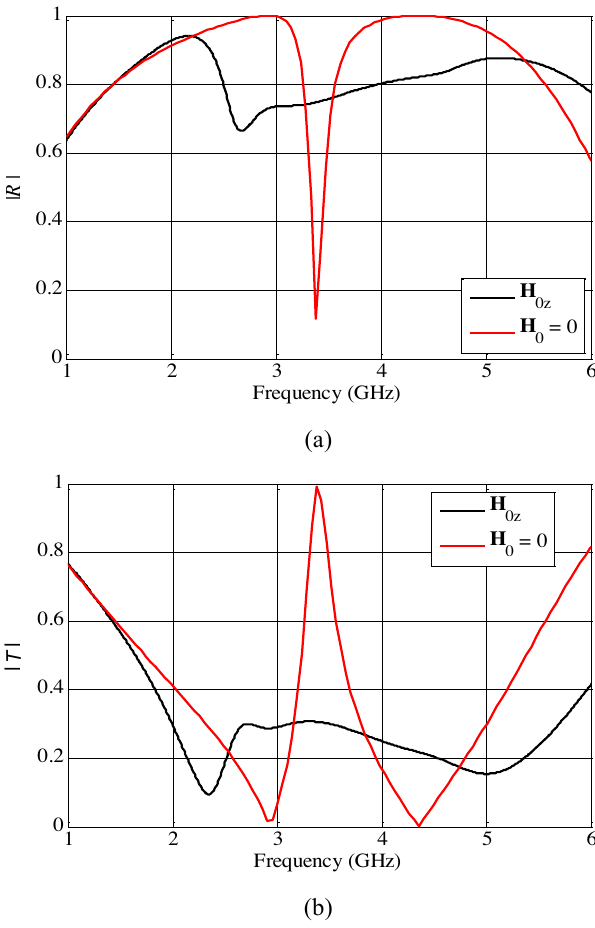
Figure 6. Reflection (a) and transmission (b) spectra of the array placed on a ferrite substrate magnetized in z - direction, and for a nonmagnetized one. The ferrite material is TT2-125 with ω /2 π = 3,5 0